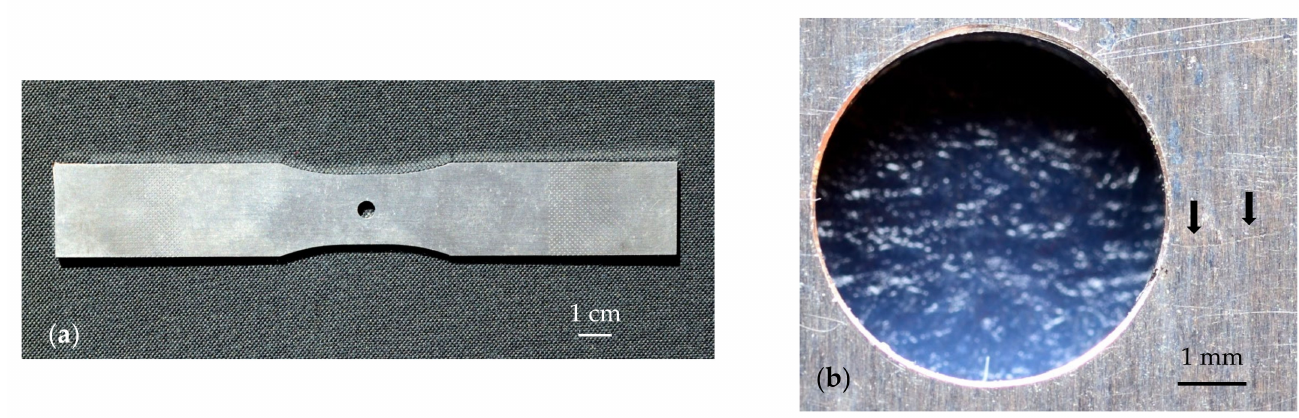
Figure 6. ( a ) Photograph of the dog bone Al-alloy plate. ( b ) Close-up picture of the sample around the hole. Arrows indicate the position of the crack, which was identified after obtaining its thermographic